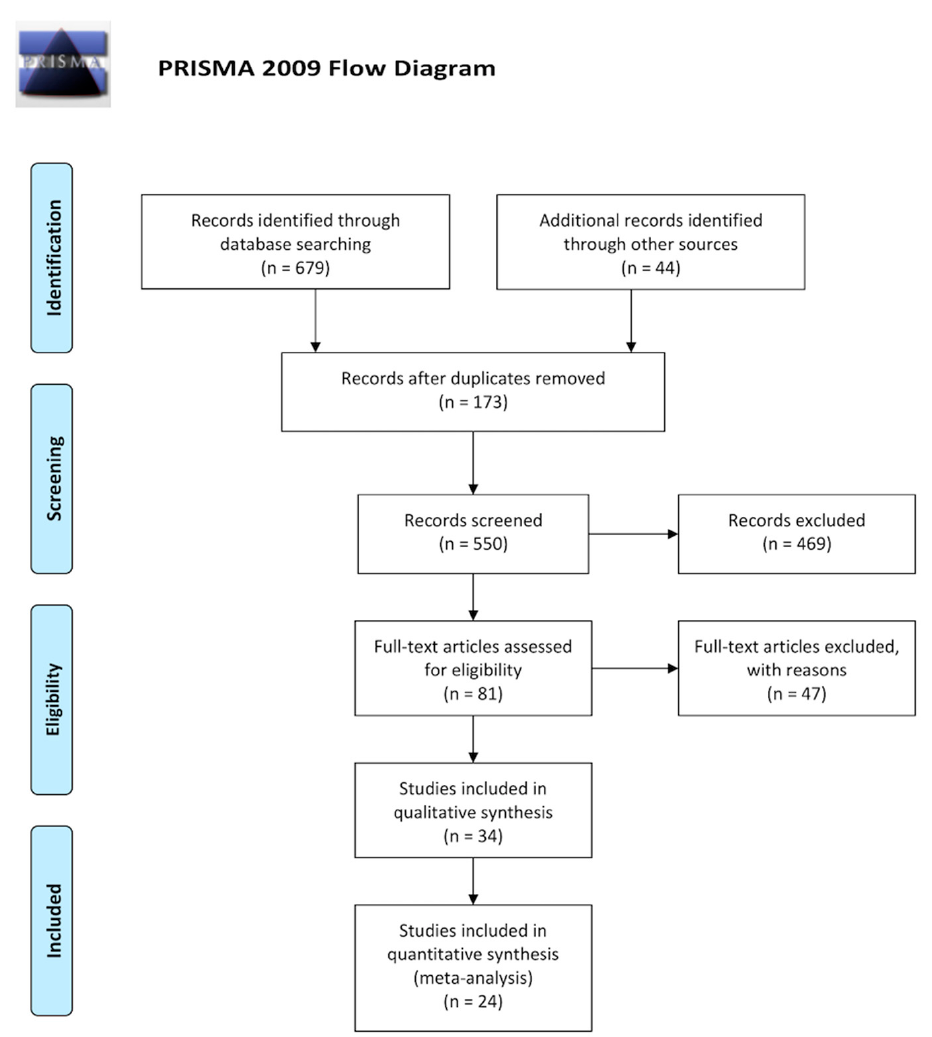
Figure 1. PRISMA flowcharts presenting our systematic review selection process for retrieving iron supplementation evidence on clinical trials. PRISMA, Preferred Reporting Items for Systematic Reviews and Meta-Analyses.